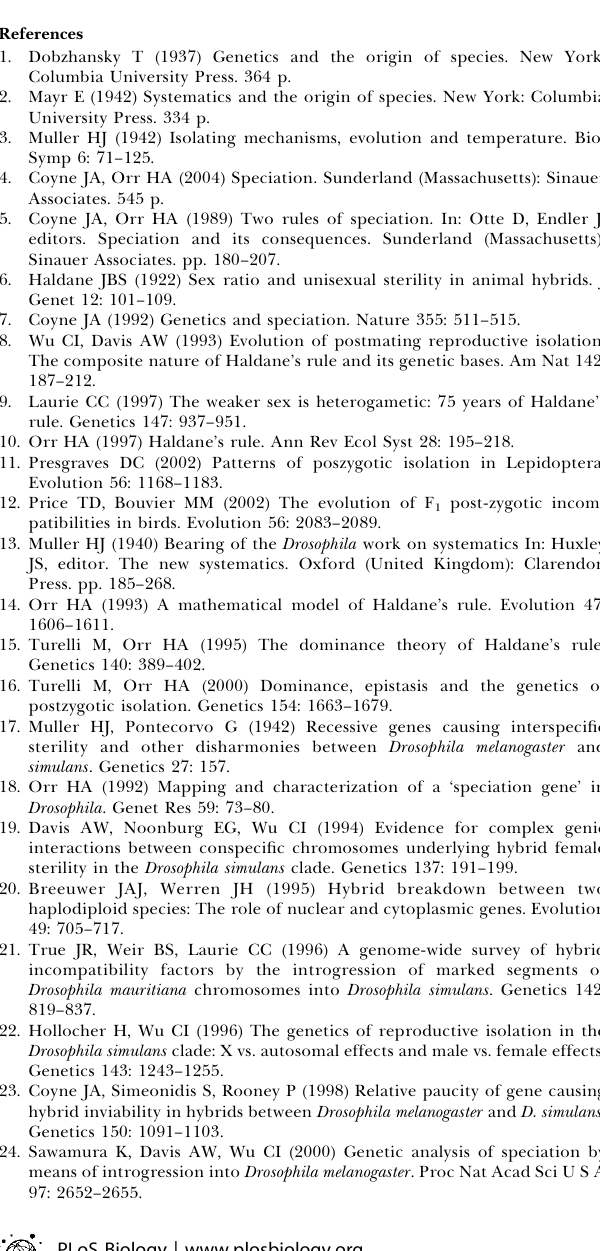
Figure S1. Estimation of Introgression Breakpoints The horizontal bar shows a hypothetical introgression: D. sechellia material is shown in white; D. mauritiana material is shown in gray;